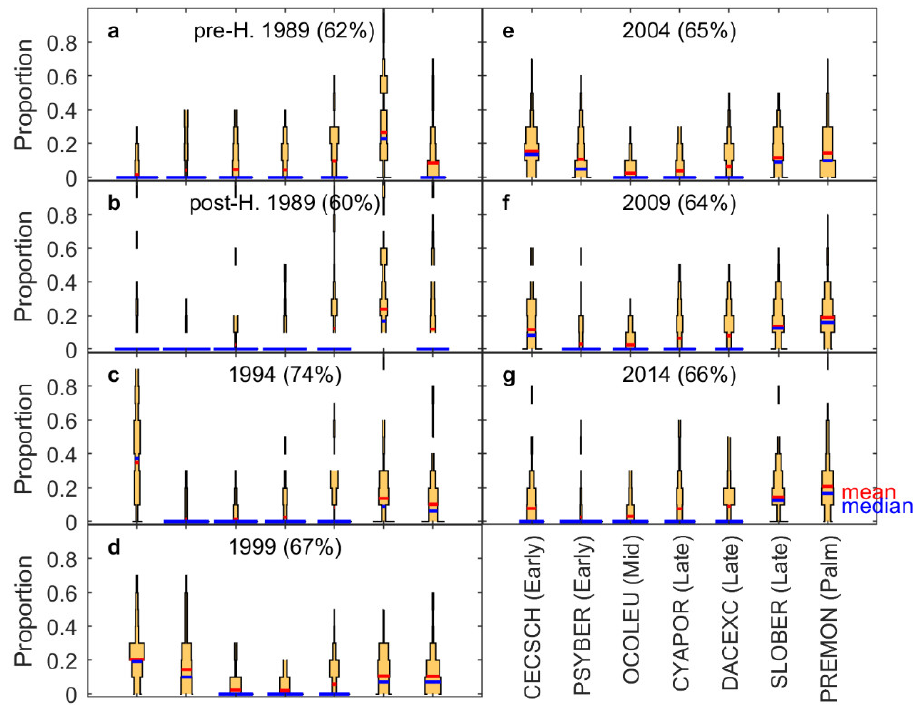
Figure 4. The probability density proportions for the seven most abundant species in each of the seven censuses at Bisley Experimental Watersheds, Luquillo, Puerto Rico. The seven censuses are ( a ) Pre-Hugo 1989, ( b ) post-Hugo 1989, ( c ) 1994, ( d ) 1999, ( e ) 2004, ( f ) 2009, and ( g ) 2014. The percentage of the abundance comprised by the top seven species in the forest per census is shown in parenthesis at the top of each panel. The x-axes are the seven species, with plant functional type (PFT) in parentheses, and the y-axes represent the proportion in 10 bins from 0.0001 to 1 and one bin for 0 proportion. The width of the yellow area represents the probability for each proportion bin; red and blue lines are the mean and median values of the proportion for all the 85 plots. A value of 0-median for a species indicates that the species is absent in more than half of the plots for that